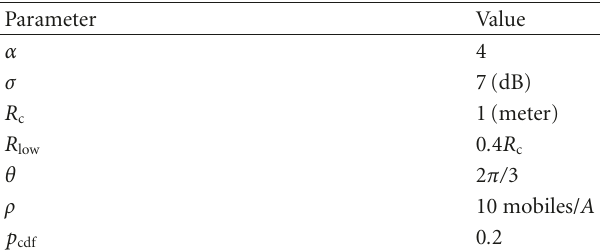
Figure 4: Outage Probability of full CSI relay selection with di ff erent number of candidate RSs’. The mean and variance values of all the branches are assumed to be 0 dB and 7dB. Table 1: Parameters assumed in the comparison of di ff erent transmission